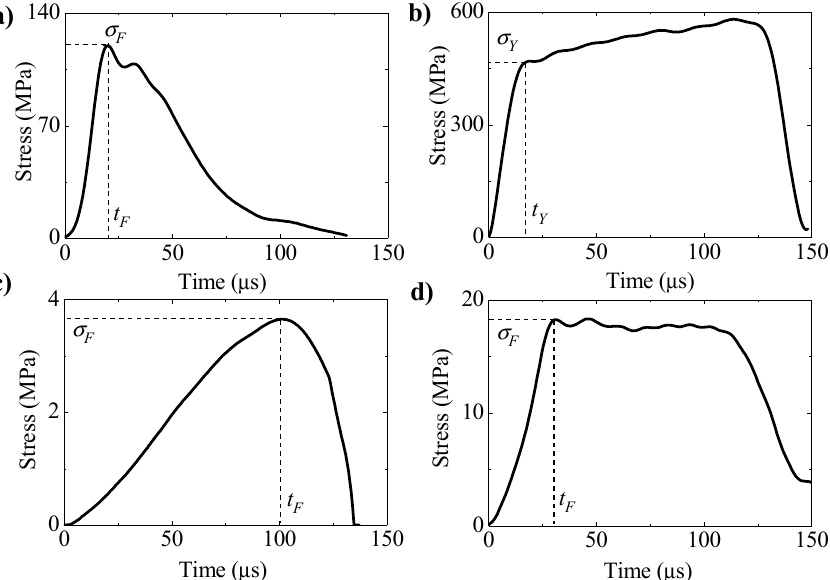
Figure 2. Typical stress diagrams in the samples at dynamic tests on a split Hopkinson pressure bar (SHPB) installation. σ F and σ Y are the critical stress (ultimate and yield stress for a given strain/stress rate), t F and t Y are the onset of failure or plastic deformation, respectively. ( a ) Dry limestone under compression (532 1/s); ( b ) ultrafine-grained (UFG) copper under compression (3800 1/s); ( c ) polymer–bitumen binder with a penetration index of 60 (PBB 60) under splitting (65 GPa/s); ( d ) bitumen PBB 60 under compression (1073 1/s).